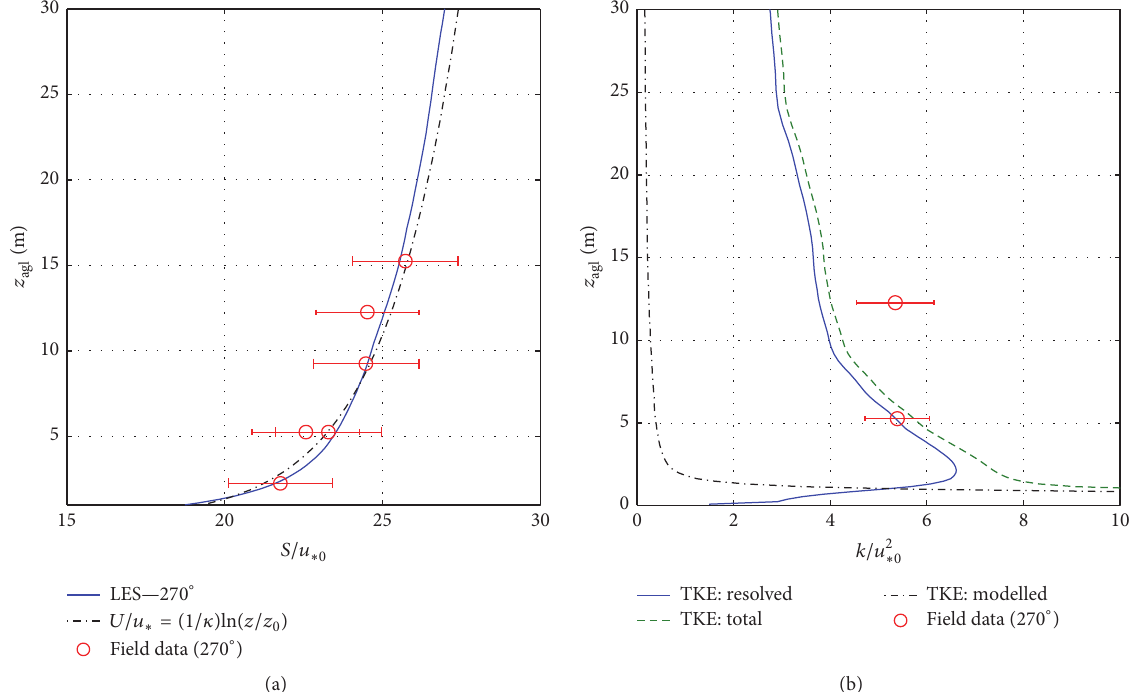
Figure 4: The LES profiles of the mean velocity magnitude (a) and the TKE (b) compared with the field measurements for the 270 ∘ wind